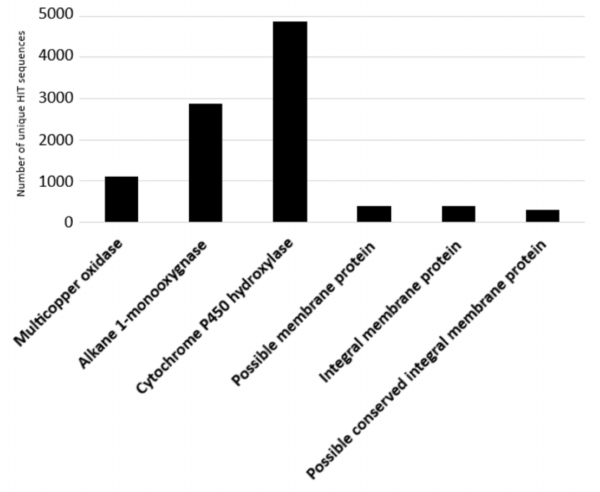
Figure 6. Number of unique HIT sequences identified in Rhodococcus genomes for different enzyme categories putatively related to C − C backbone plastic degradation.